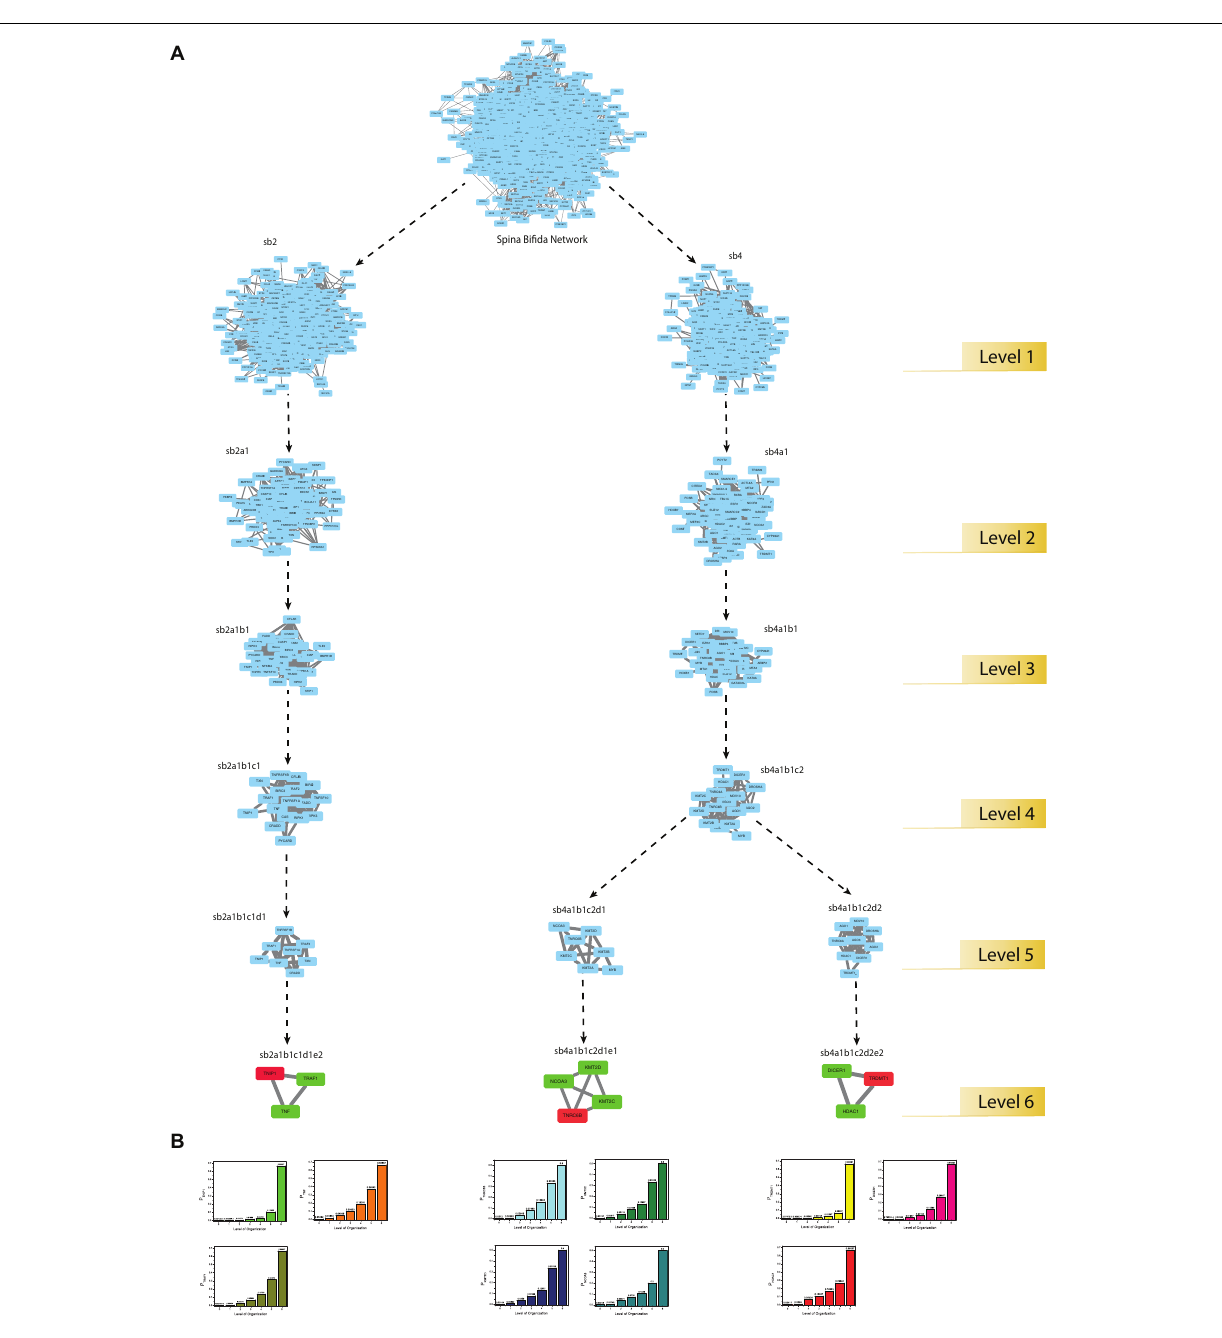
addition, a low-degree bridge node, connecting two high-degree nodes, is very important in a network despite its lower degree (Liu et al., 2016). Thus, a node’s degree is not the sole determinant of its essentiality, rather, it depends on the topological position of that node. This is reflected in our results, where, the three seed genes, i.e., TNIP1 , TNRC6B , and TRDMT1 have a relatively low degree compared to their interacting partners in the